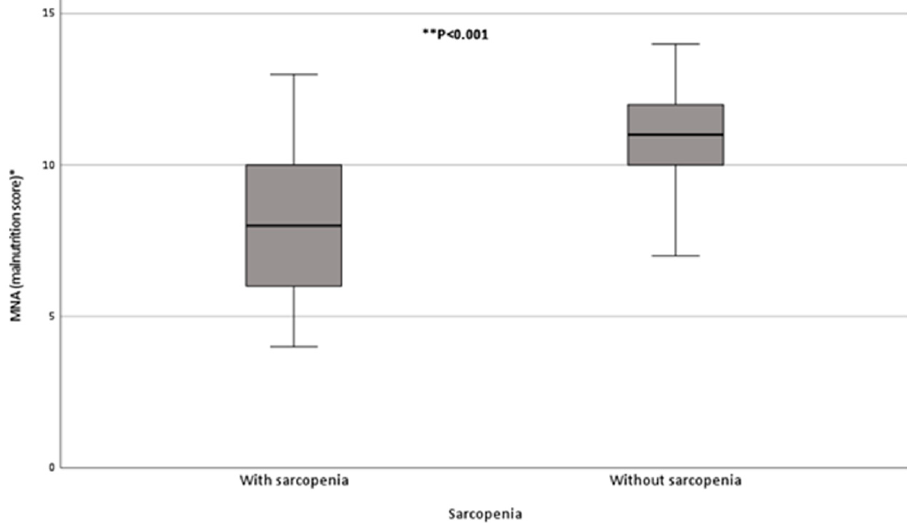
Figure 2. Malnutrition score (assessed by MNA-SF) among participants with and without sarcopenia. Participants with Sarcopenia had lower median (25th, 75th percentiles) MNA-SF score than those